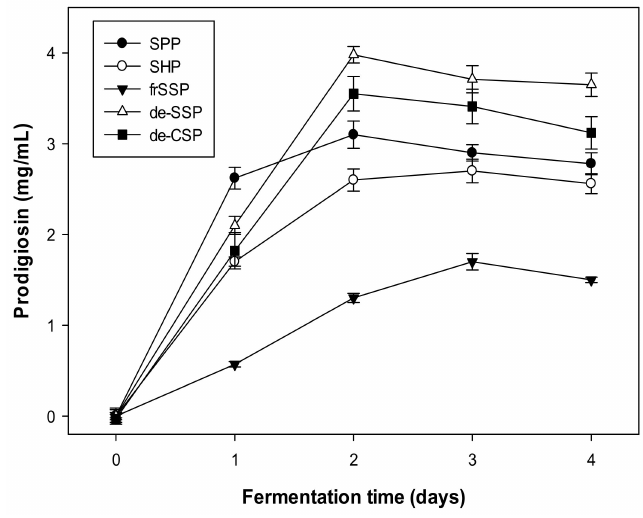
Figure 1. Bioproduction of PG by S. marcescens TNU02 by fermentation using various MCWs, such as squid pen powder (SPP), shrimp head powder (SHP), fresh shrimp shell powder (fr-SSP), demineralized crab shell powder (de-CSP), and demineralized shrimp shell powder (de-SSP), as major C/N sources with supplementary casein as a free protein at the ratio of 7.0/3.0. The C/N source (1.60%) was added to a liquid medium of 0.03% K 2 HPO 4 and 0.05% CaSO 4 . The fermentation was performed for two days at 150 rpm (shaking speed) in the dark at 25°C. The error bars in the figures are standard errors (SE).